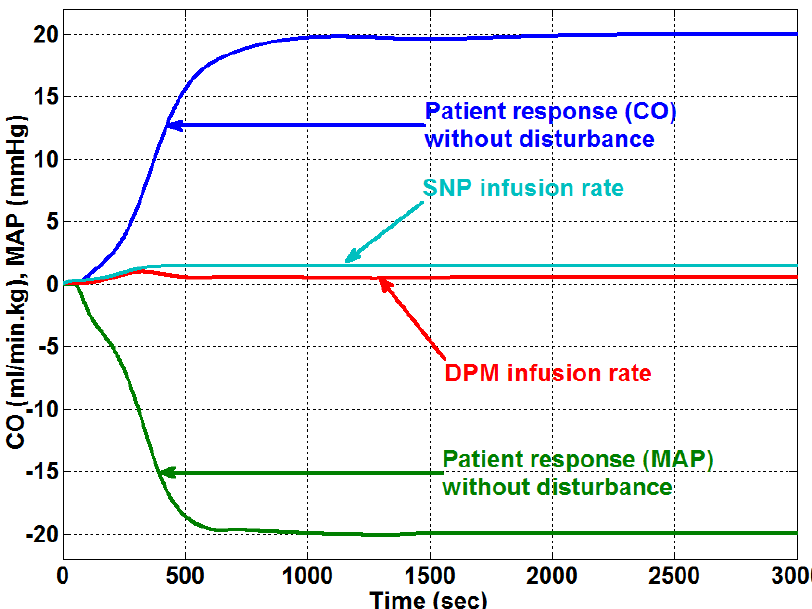
Figure 7: Nominal response without disturbance when set point changes are +20 for CO and -20 for MAP